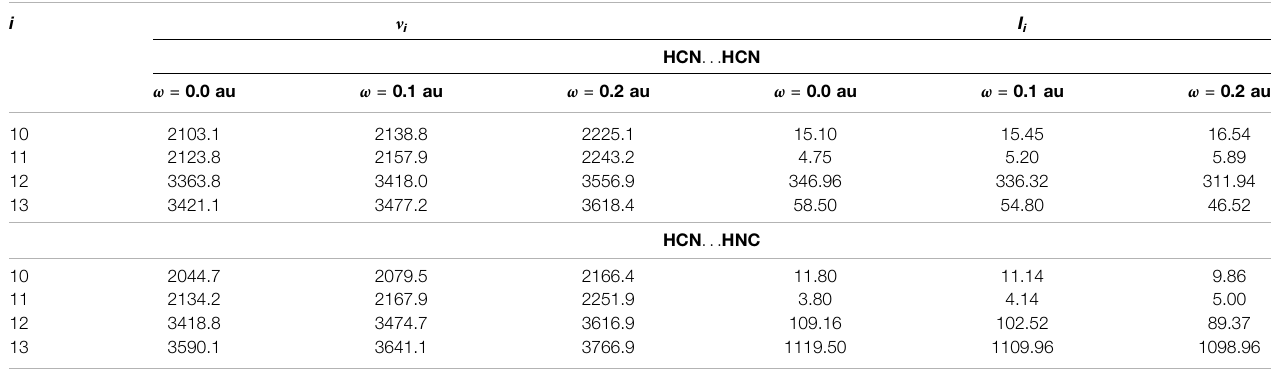
TABLE 2 | Frequencies ( ] i , in cm − 1 ) and infrared intensities ( I i , in km/mol) for vibrational normal modes i of HCN ... HCN and HCN ... HNC complexes computed at the CCSD(T)/aug-cc-pVTZ level of